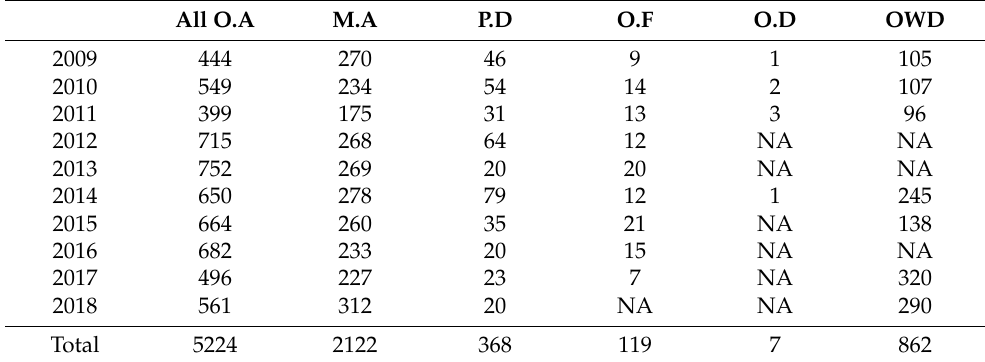
Table 1. The main Occupational Safety and Health (OSH) statistics between the years 2009 and 2016 according to the Ministry of Labor (MoL). All O.A M.A P.D O.F O.D